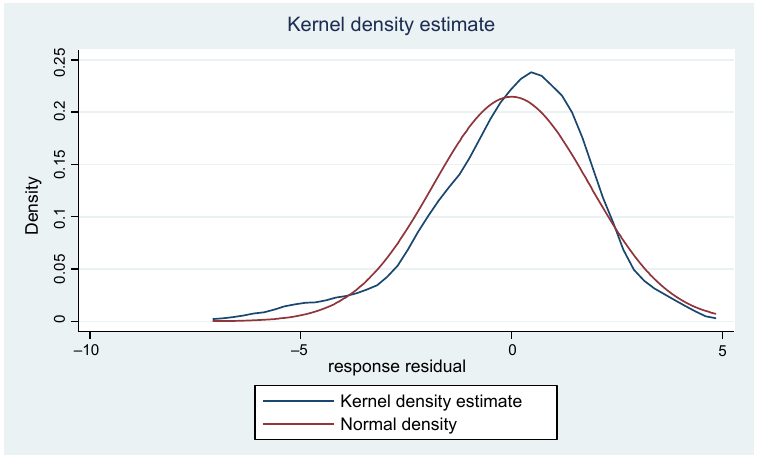
Figure 1. Normality